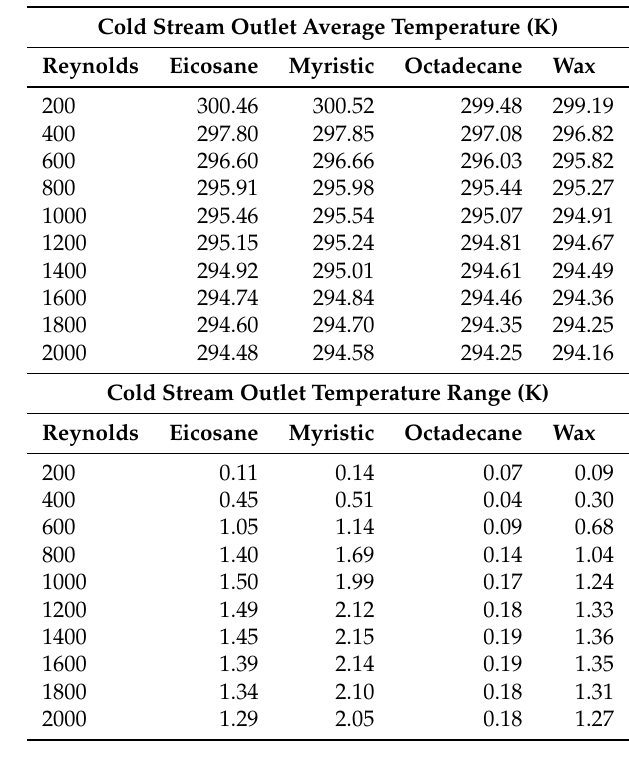
Figure 10. Average temperature and oscillation range for the cold stream outlet as a function of Reynolds number and phase change material. As Reynolds increases a general trend in decrease of the average temperature is seen due to decreased residence time within the pipe. Oscillations also become larger as heat transfer rates increase with no change in the amount of thermal mass being engaged. In the case of eicosane, more material phase changes at higher Reynolds which causes the oscillations to dampen. Table 7. Range and Average temperature for the cold outlet of the PCM capacitors at different Reynolds